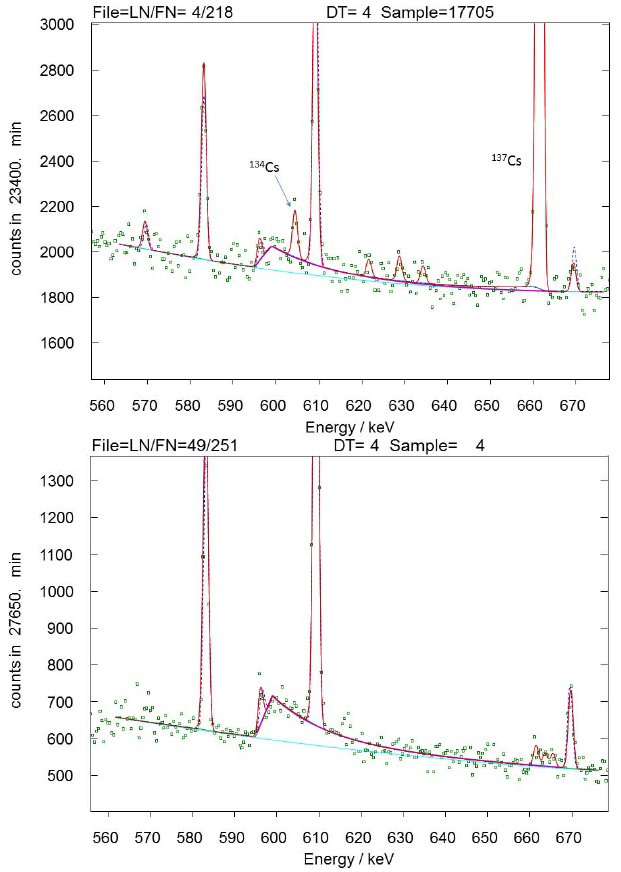
Fig. A1. Upper panel: 134 Cs (at 605keV) and 137 Cs (at 662keV) = 1 . 21 ) ; the red peaks fitted in the region 560–665keV ( χ 2 R coloured curves show the peak fitting functions residing above a 3- parameter polynomial background continuum (light cyan); dashed peak curves indicate the peaks sizes obtained from separate back- ground measurements. Note the broad neutron-induced background peak beneath the peaks of 605 and 609keV; after accounting for dif- ferent counting durations its fitted height parameter agrees to within 8% with that fitted in the separate background spectrum. The three small peaks between 609 and 662keV were found to be not sig- nificant. Lower panel: spectrum region of the corresponding back- ground spectrum showing more clearly the neutron-induced back- ground peak beneath and no 134 Cs,